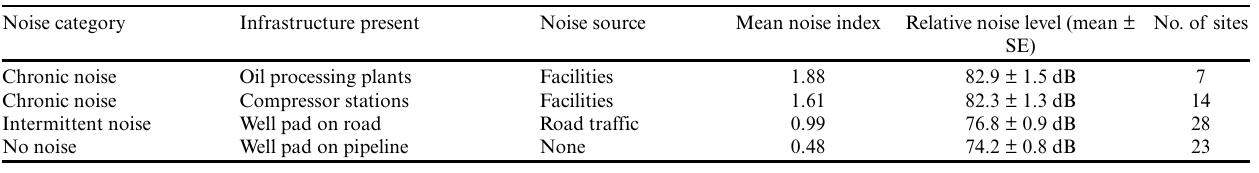
Table 1 . Details of the different types of sites surveyed for owls. Noise level was assessed first by listening to 3–4 recordings, the level of industrial noise was ranked by listeners using these index codes: (0) no noise, (1) low and distant, (2) moderate, and (3) very loud and close. A modal noise index was determined for each station, and a mean noise index was calculated for sites surveyed with different industrial infrastructure. Noise level was also assessed by measuring the relative noise level on both the left and right channels on 1–2 recordings from each station where there were no species vocalizing and no wind or rain on the recordings in Raven Pro version 1.5.